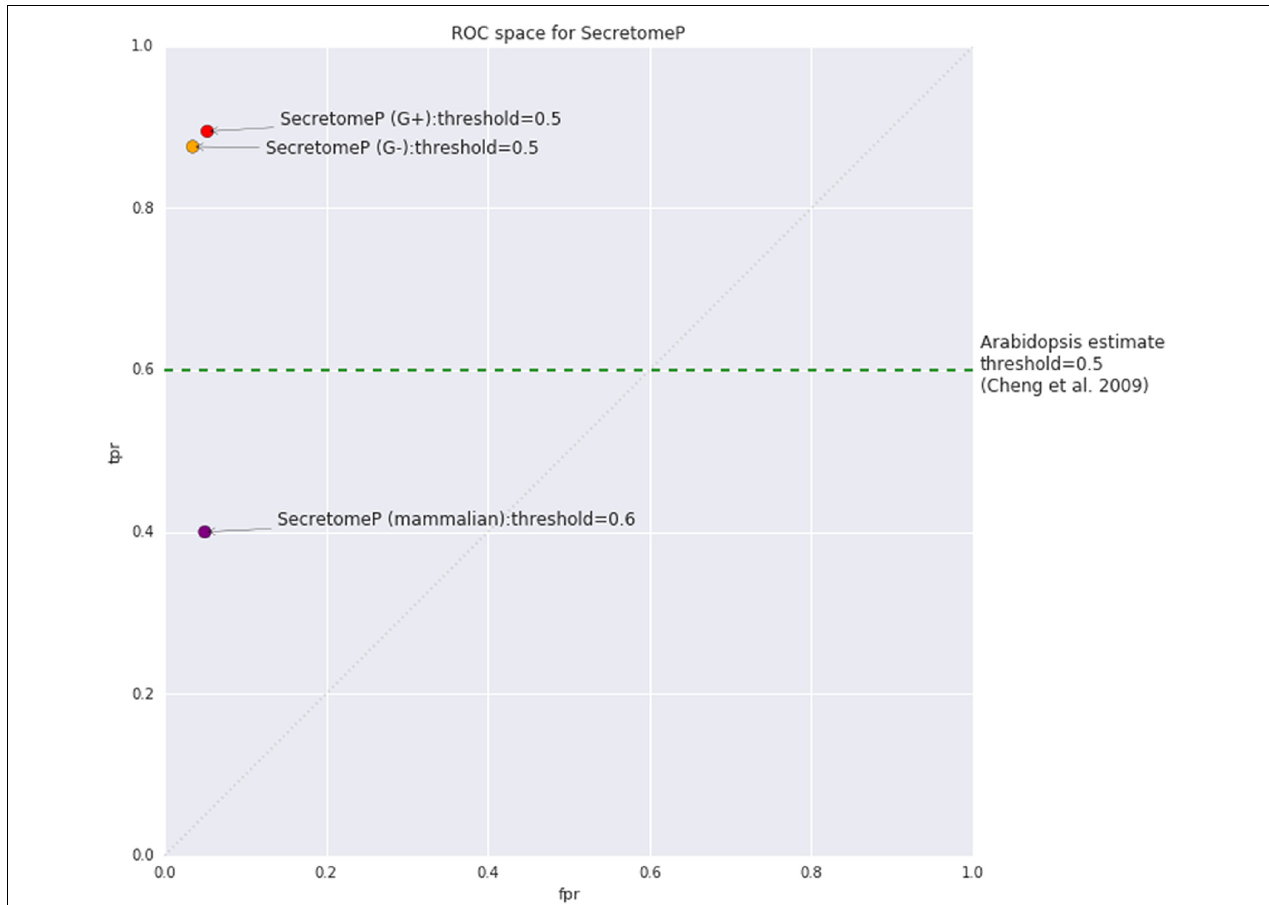
FIGURE 1 | Estimated true positive rate (TPR) and false positive rate (FPR) for SecretomeP as published for mammalian proteins (v1) based on internal cross-validation and bacterial proteins (v2) based on performance on classically secreted proteins (CSPs) from the SignalP 3.0 dataset. The estimated TPR of SecretomeP on plants as stated by Cheng et al. (2009) was 0.6, with no FPR given. The random line diagonal represents equal TPR and FPR, equivalent to random selection of classes.